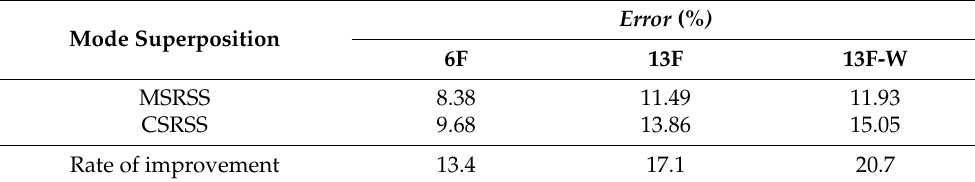
Table 2. Deviation of the results between RSA and RHA.